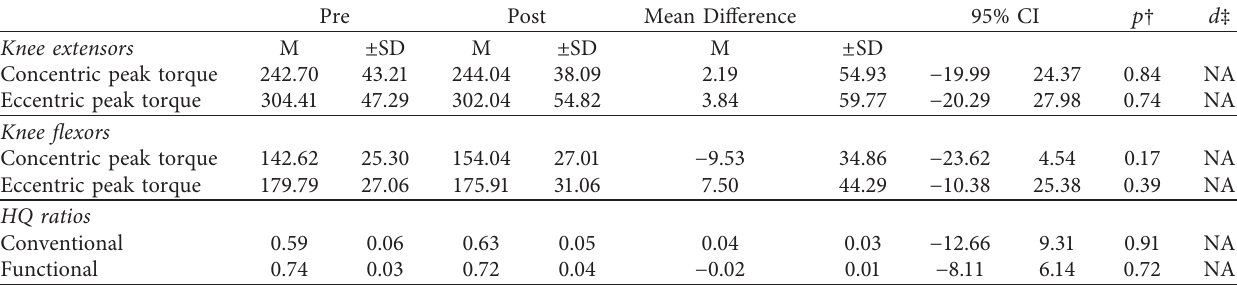
Table 2: Team A strength values before (pre) and after (post) quarantine period. Pre